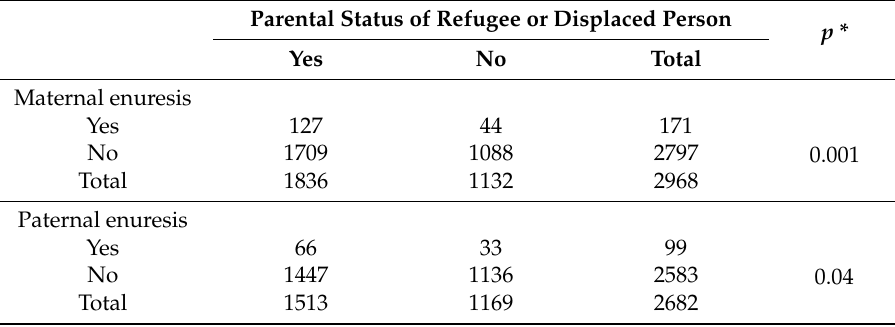
Table 3. Parental refugee or displaced person status and their enuresis in